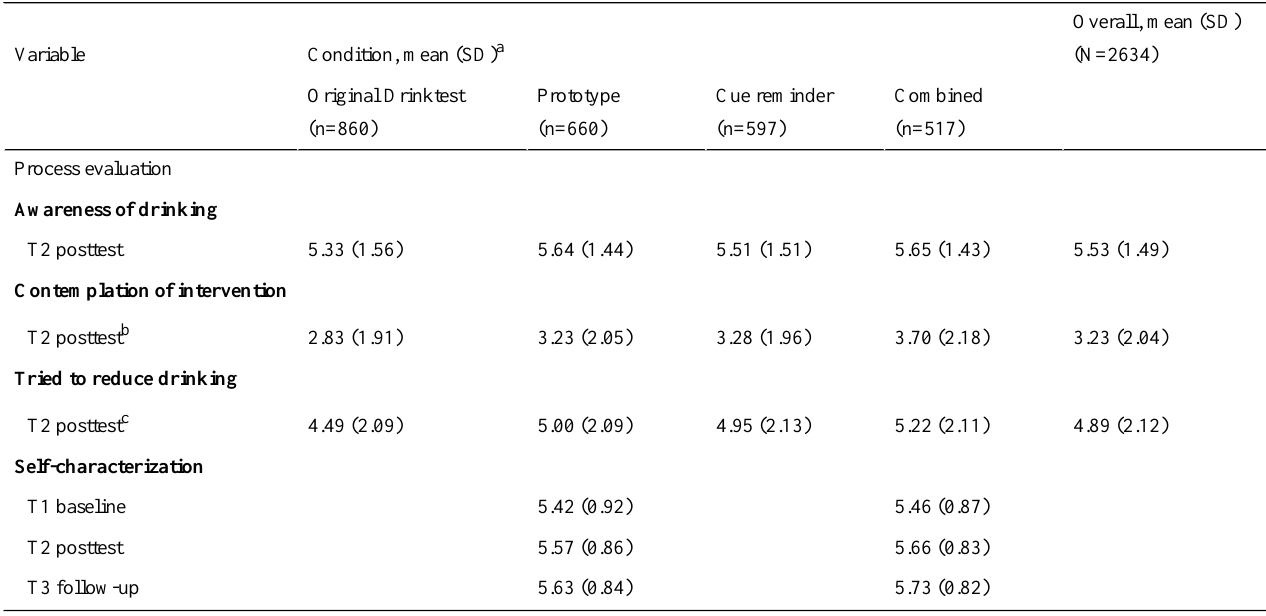
Overall, mean (SD)